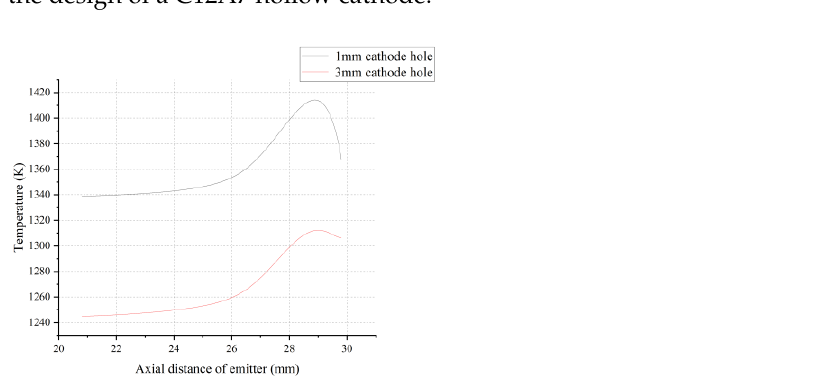
Figure 11. Axial temperature of the emitter along the axis of symmetry in the